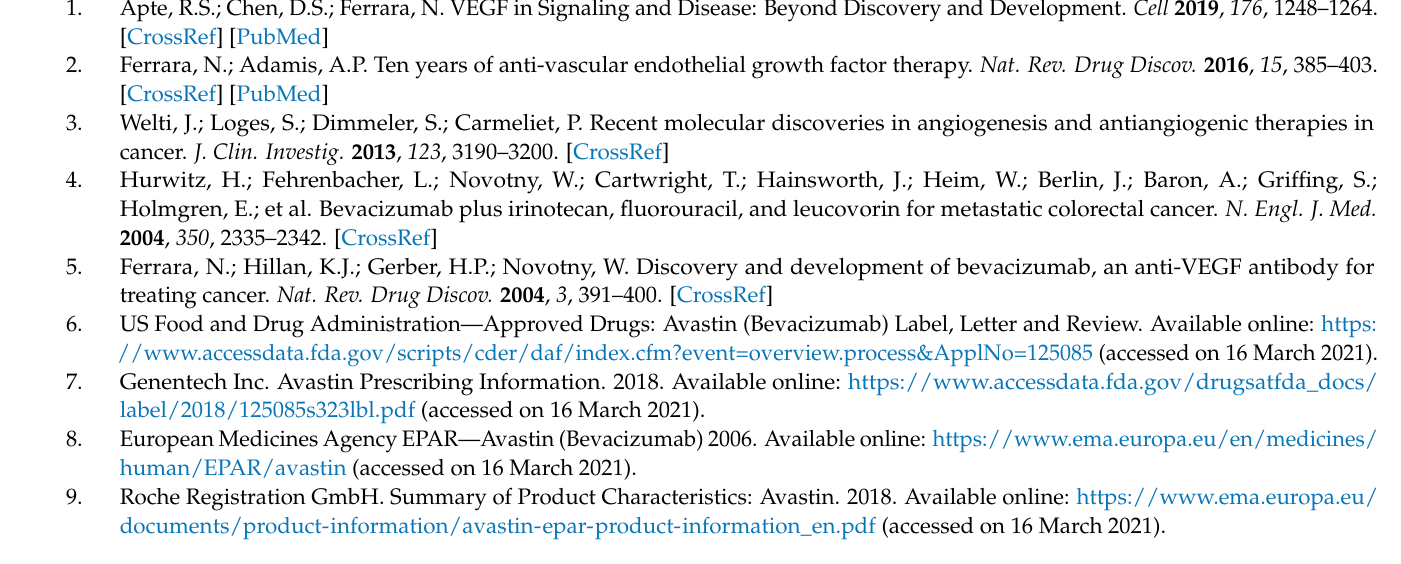
studies of candidate preparation 18/210 tested using the HUVEC-based VEGF neutralization assays. Table S4: Summary of results from reconstitution stability studies of candidate preparation 18/210 tested using the HUVEC-based VEGF neutralization assays. Table S5: Summary of results from freeze–thaw stability studies of candidate preparation 18/210 tested using the HUVEC-based VEGF neutralization